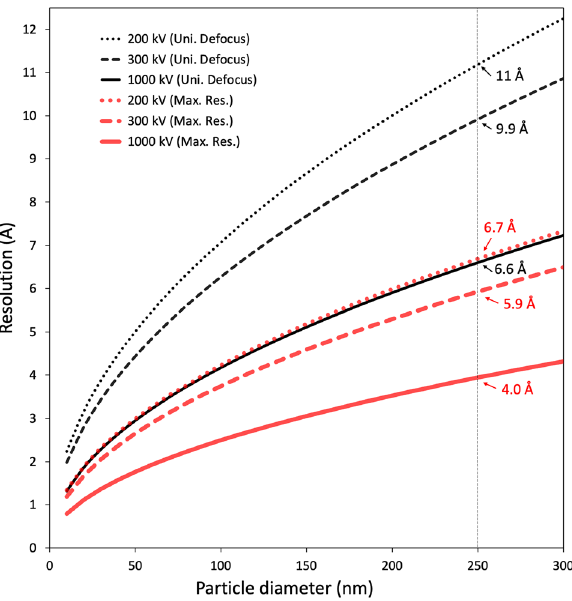
Figure 1. The depth of field effect in cryo-EM. Theoretical resolution limits caused by the size of particles (Eq. 1) are plotted at accelerating voltages of 200, 300 and 1000 kV, assuming uniform defocus (Black curves). The resolutions at which phase error limits the theoretical maximum resolution of a cryo-EM reconstruction (Eq. 2) are plotted at accelerating voltages of 200 kV, 300 kV and 1000 kV (Red curves). Dashed vertical line drawn at the maximum diameter (250 nm) of tokyovirus. Theoretical resolution limits at the maximum diameter of tokyovirus are shown to one decimal